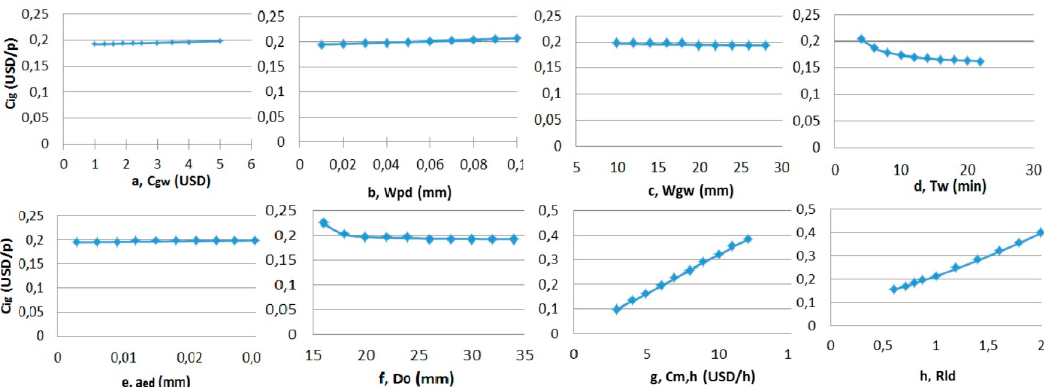
Figure 1. Grinding cost versus input factors.